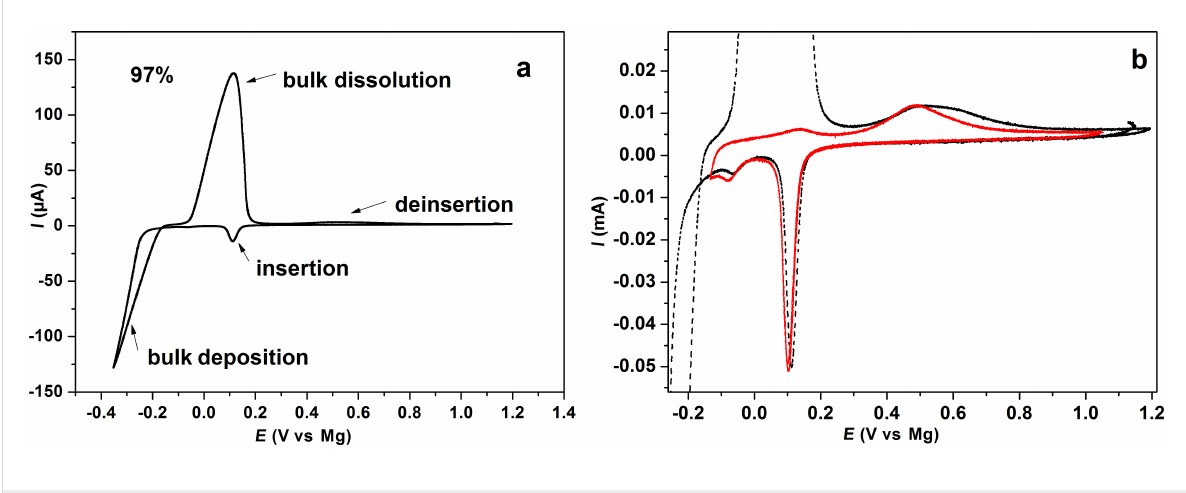
Figure 10: (a) Cyclic voltammograms of Mg deposition/dissolution and Mg insertion/de-insertion at the single Au electrode (Au(111)) in MACC/ tetraglyme at a sweep rate of 1 mV s − 1 . (b) Details of Mg insertion/de-insertion at the Sb-modified electrode in the potential range of − 0.1 V to 1.1 V.